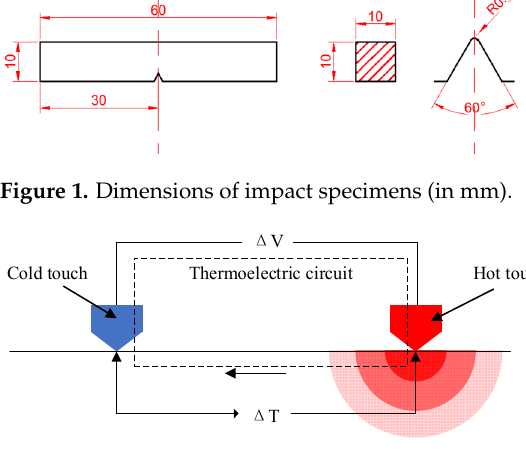
Figure 2. Thermoelectric test system.